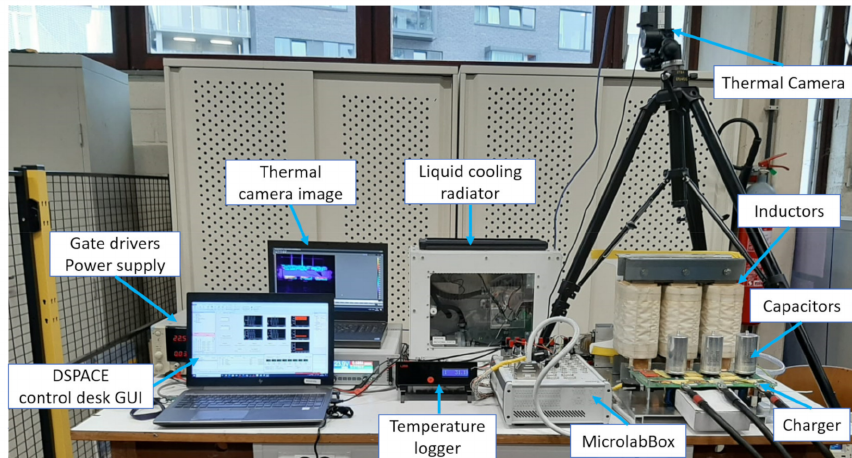
Figure 15. Off–board charger test setup.